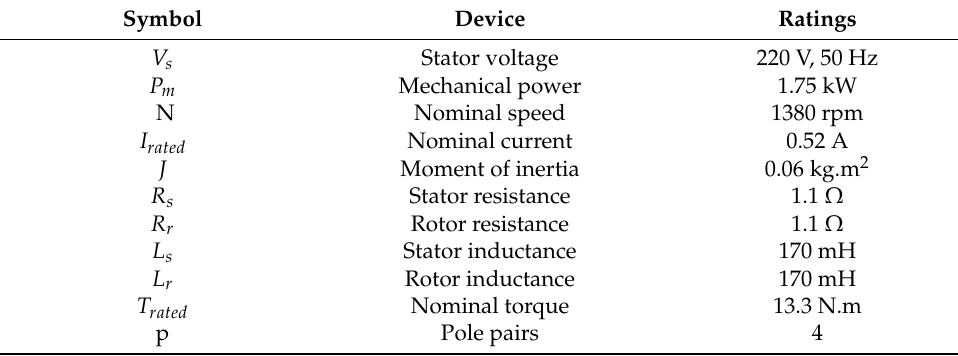
Table A2. Specifications of the